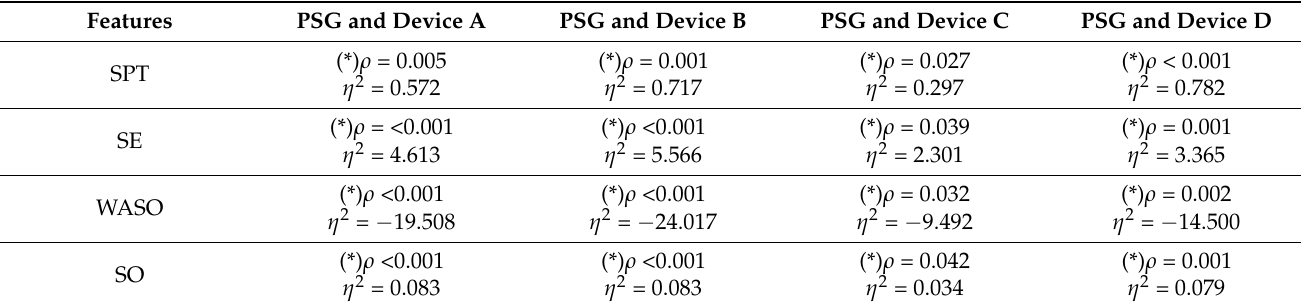
“(*)” indicates significant difference between the device and PSG system, for a significance level ρ = 0.05. The power of the test η 2 indicates the separation between sleep features from the wearable devices and those from the PSG; the larger the η 2 , the more different the device and the